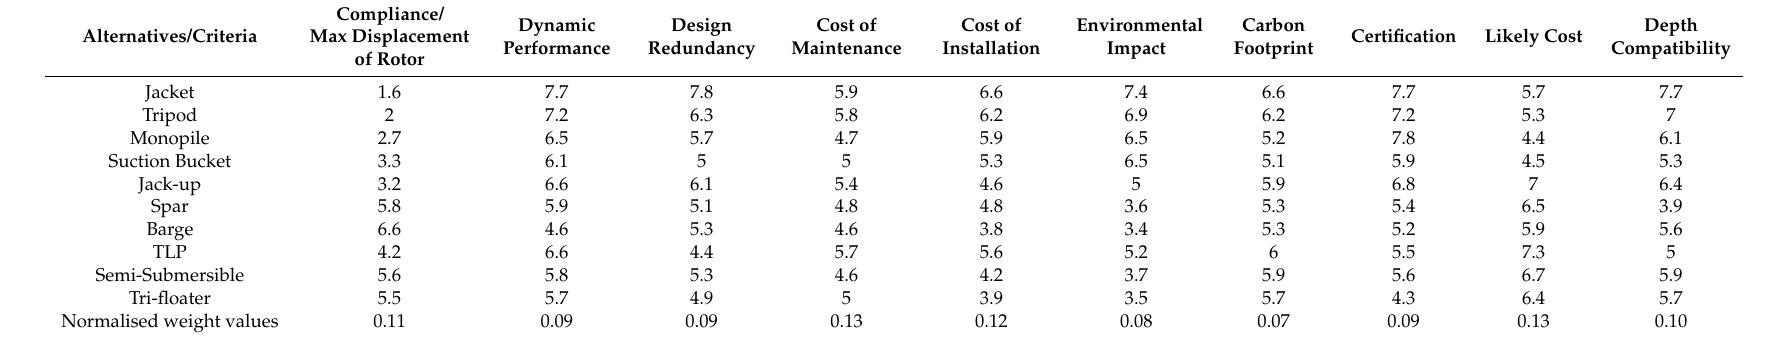
Table 4. Mean evaluation values (design matrix) and normalised mean values of the weights.